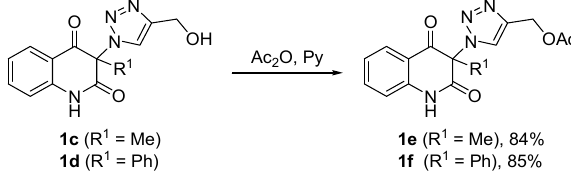
Table 3. Preparation of compounds 7